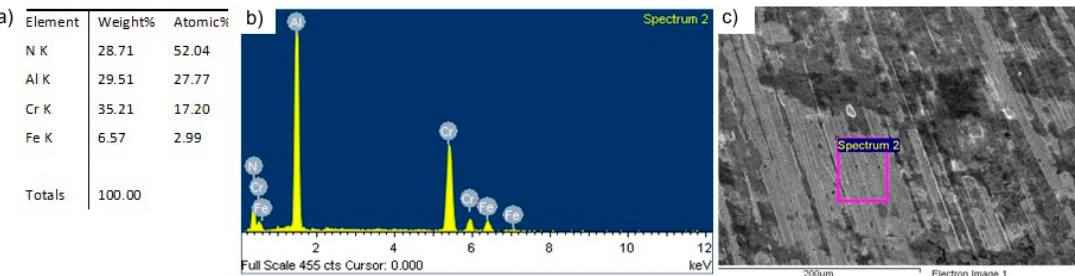
Figure 7. SEM/EDS analysis of the chemical composition of the shoulder surface of the tool with the AlCrN coating after the first stage of testing: ( a ) content of elements, ( b ) EDS spectrum, ( c ) surface analyzed. The tool working surfaces after the second stage of testing are presented in Figure 8.